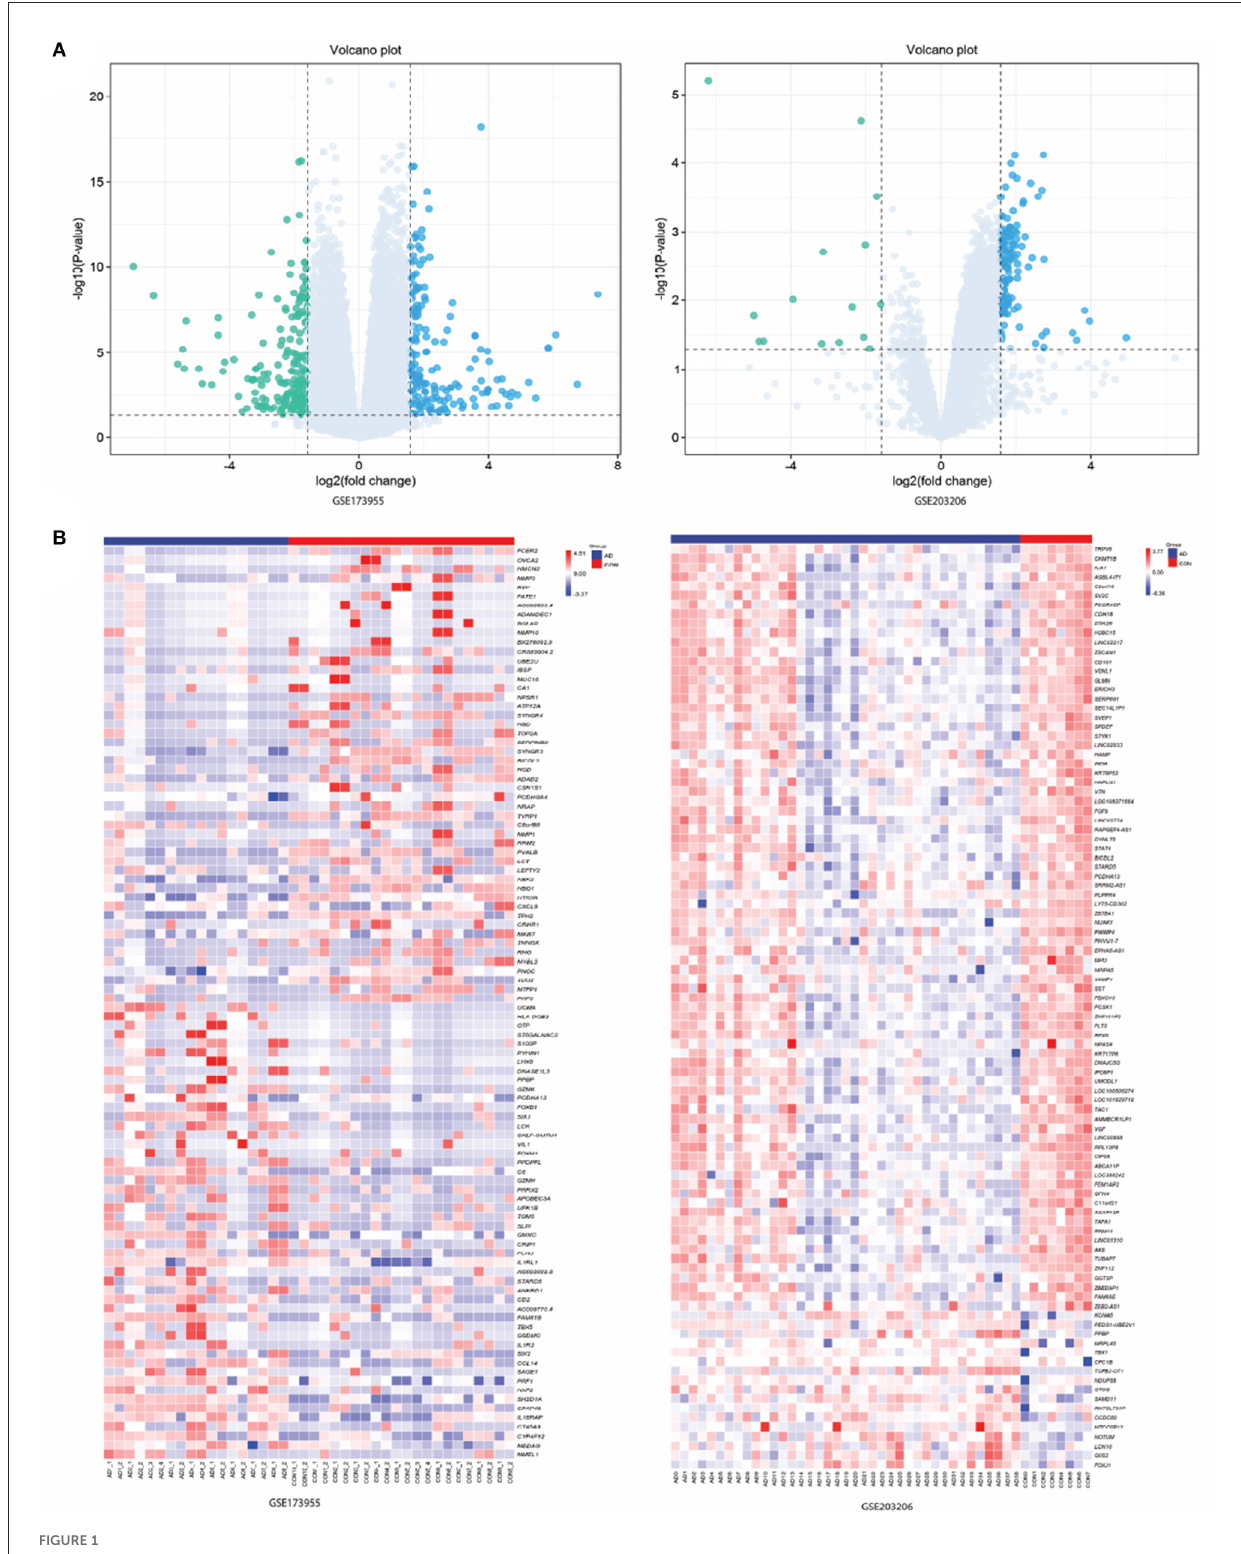
FIGURE1 Results of screening differentially expressed genes (DEGs). (A) Volcano maps of gene expression in GSE173955 and GSE203206. Green data dots represent down-regulated DEGs. Data points in light blue and gray represent genes with up-regulated and not significantly different expressions, respectively. (B) Heatmap of top 100 DEGs in GSE173955 and